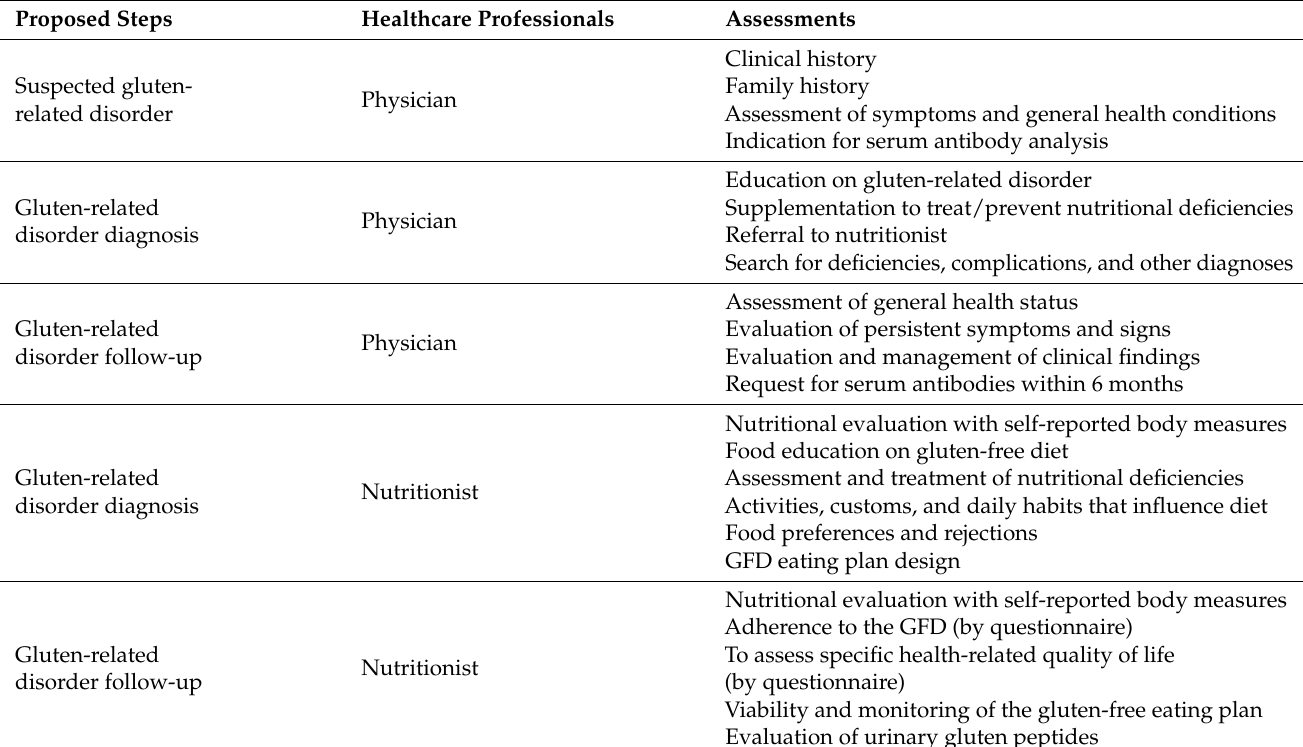
Table 1. Proposed steps to monitor the GFD via